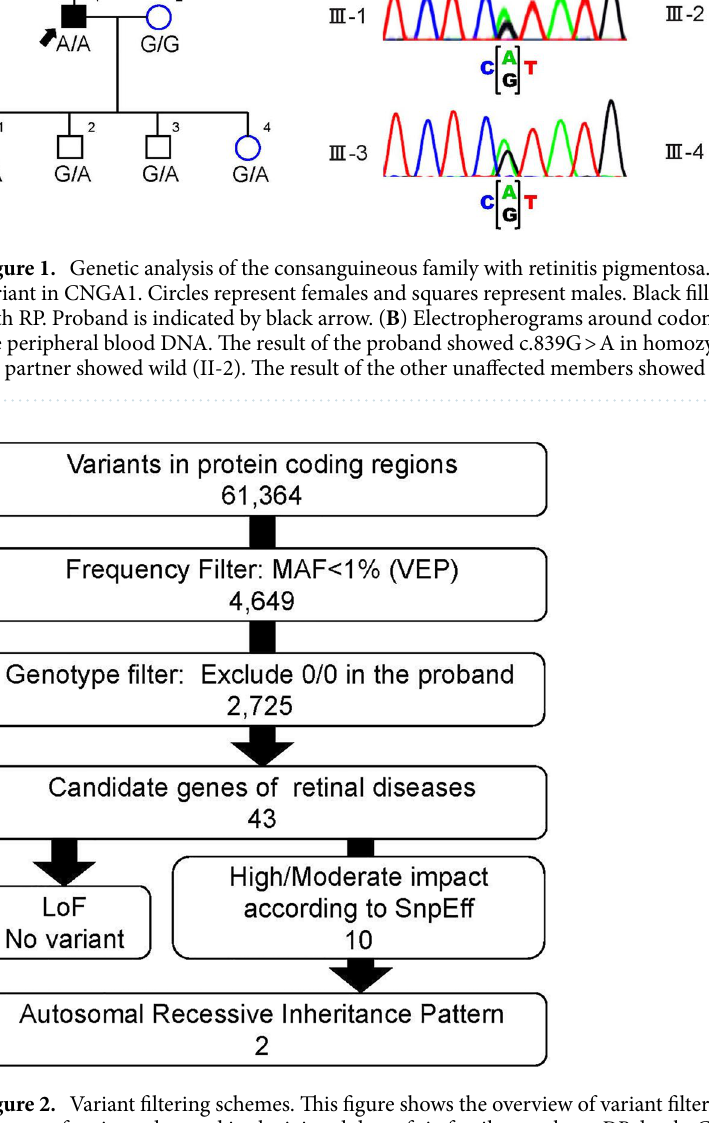
Figure 2. Variant filtering schemes. This figure shows the overview of variant filtering steps. The number shows the sum of variants detected in the jointed data of six family members. DP depth, GQ genotype quality, Lof loss of function, MAF minor allele frequency, VEP Ensembl Variant Effect